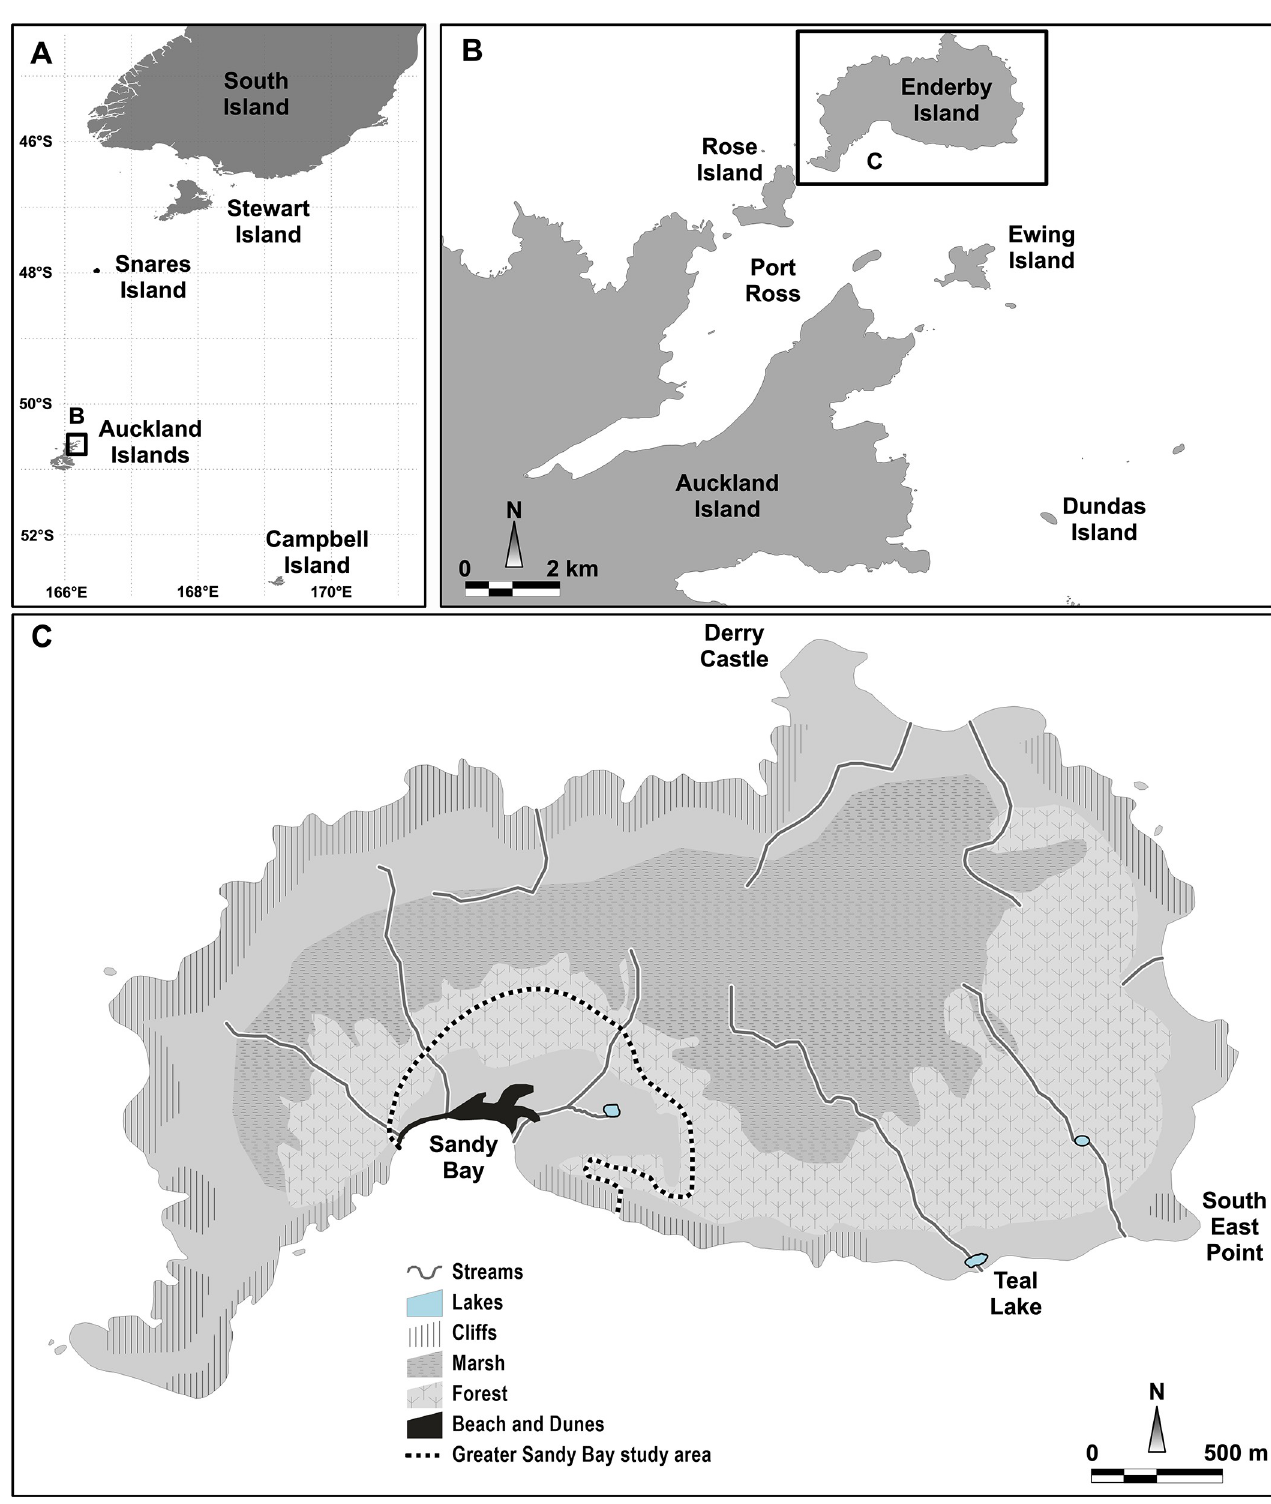
Fig 1. Map of New Zealand sea lion ( Phocarctos hookeri ) breeding areas. (A) Outline of all breeding sites, including the South Island of mainland New Zealand, Stewart Island, Auckland Islands and Campbell Island. (B) Breeding sites at the northern Auckland Islands including Enderby Island and Dundas Island. Port Ross islands are common dispersal sites. (C) Localities of Enderby Island including the study site, the greater Sandy Bay area.